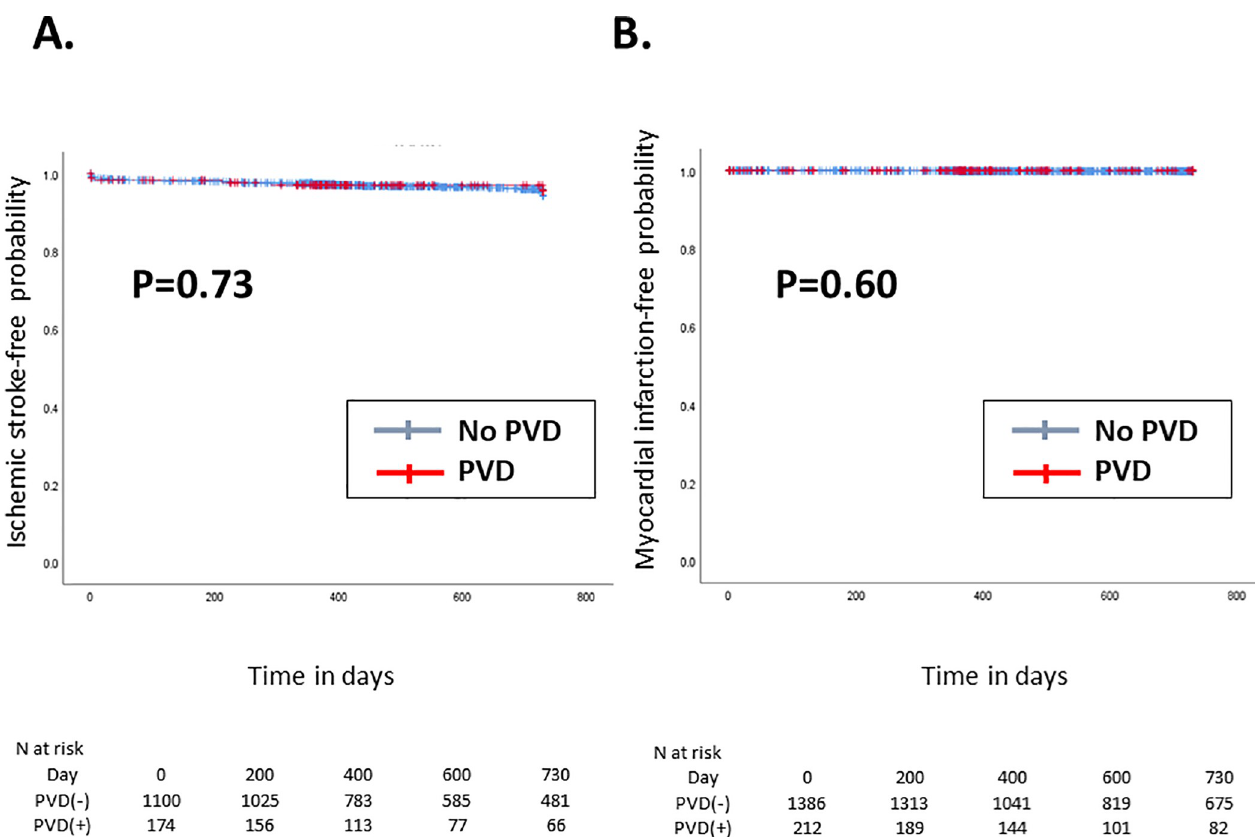
Fig 3. Kaplan–Meier curve of the 2-year (A) ischemic stroke-free and (B) myocardial infarction-free rates. Red and blue lines indicate patients with and without PVD, respectively. PVD = polyvascular disease.